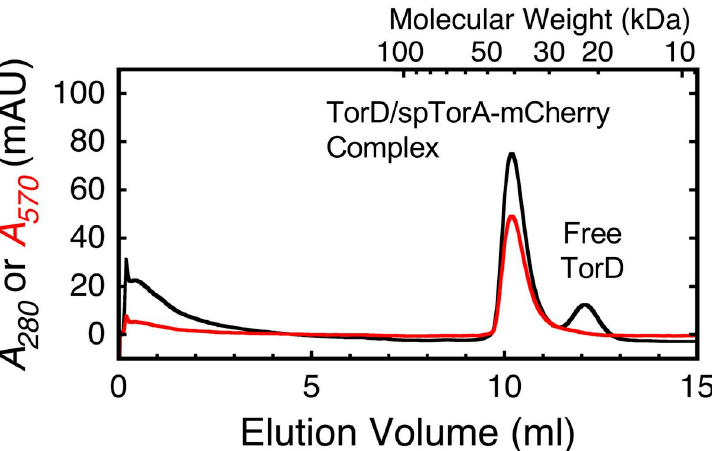
Fig 4. Dissociation of the TorD/spTorA-mCherry complex. Fractions 19–21 of the 1:1 TorD/spTorA-mCherry complex in Fig 3A were pooled, centrifuged to remove aggregates (4˚C, 32,000 g for 10 minutes), and immediately re- run on the size-exclusion column. Approximately half of the TorD dissociated from spTorA-mCherry (see text).